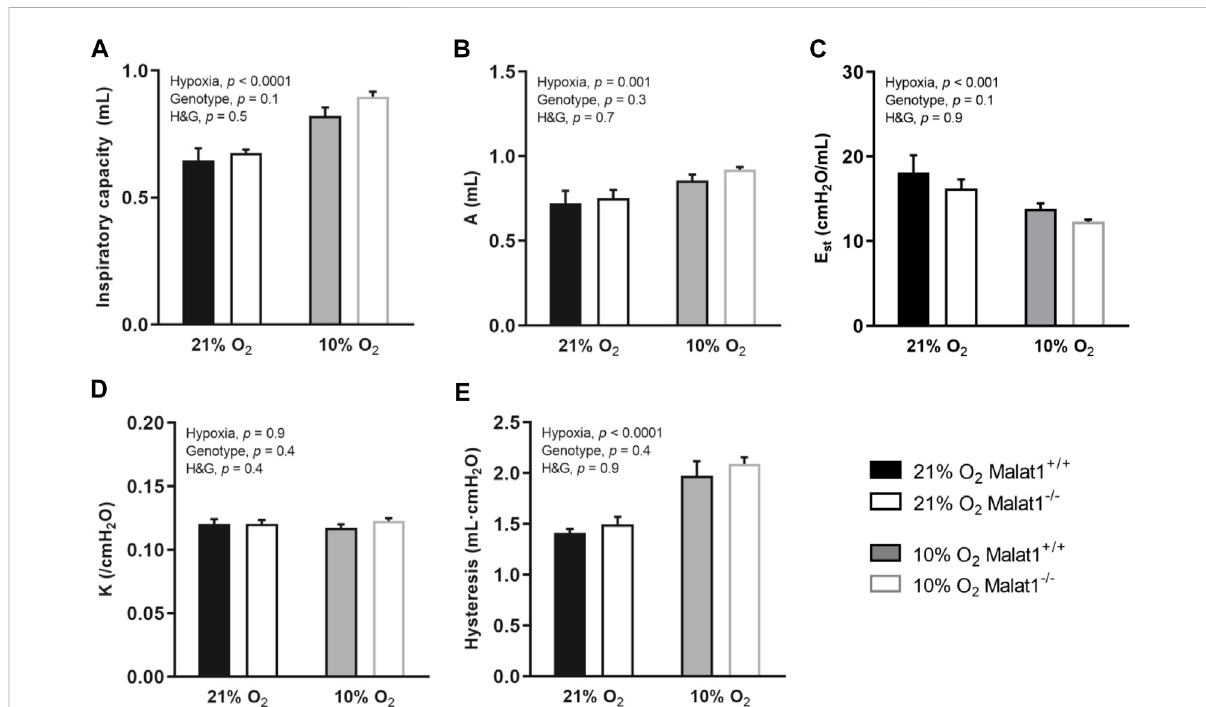
FIGURE 3 In vivo respiratory mechanics measured over a large range of lung volumes at baseline. Inspiratory capacity (A) ; the parameter A of Salazar- Knowles ’ equation (B) ; quasi-static elastance (Est) (C) , the parameter K of Salazar-Knowles ’ equation (D) ; and hysteresis (E) in Malat1 +/+ and Malat1 − / − micehoused innormoxiaorhypoxia for8 days. n =8, 8,11and10for Malat1 +/+ innormoxia, Malat1 − / − innormoxia, Malat1 +/+ inhypoxiaandMalat1 − / − in hypoxia groups, respectively. Data were analyzed by two-way